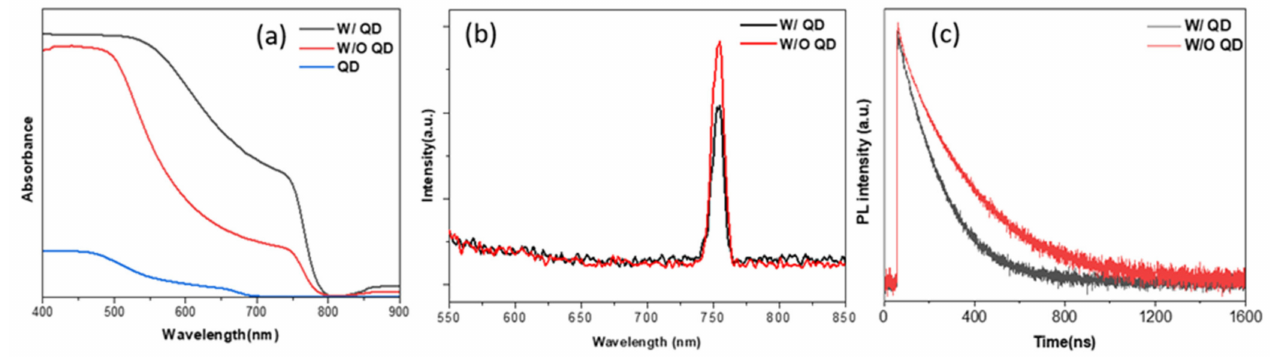
Figure 4. ( a ) The absorbance spectra; ( b ) PL spectrum; and ( c ) TRPL decay curves for MAPbI 3